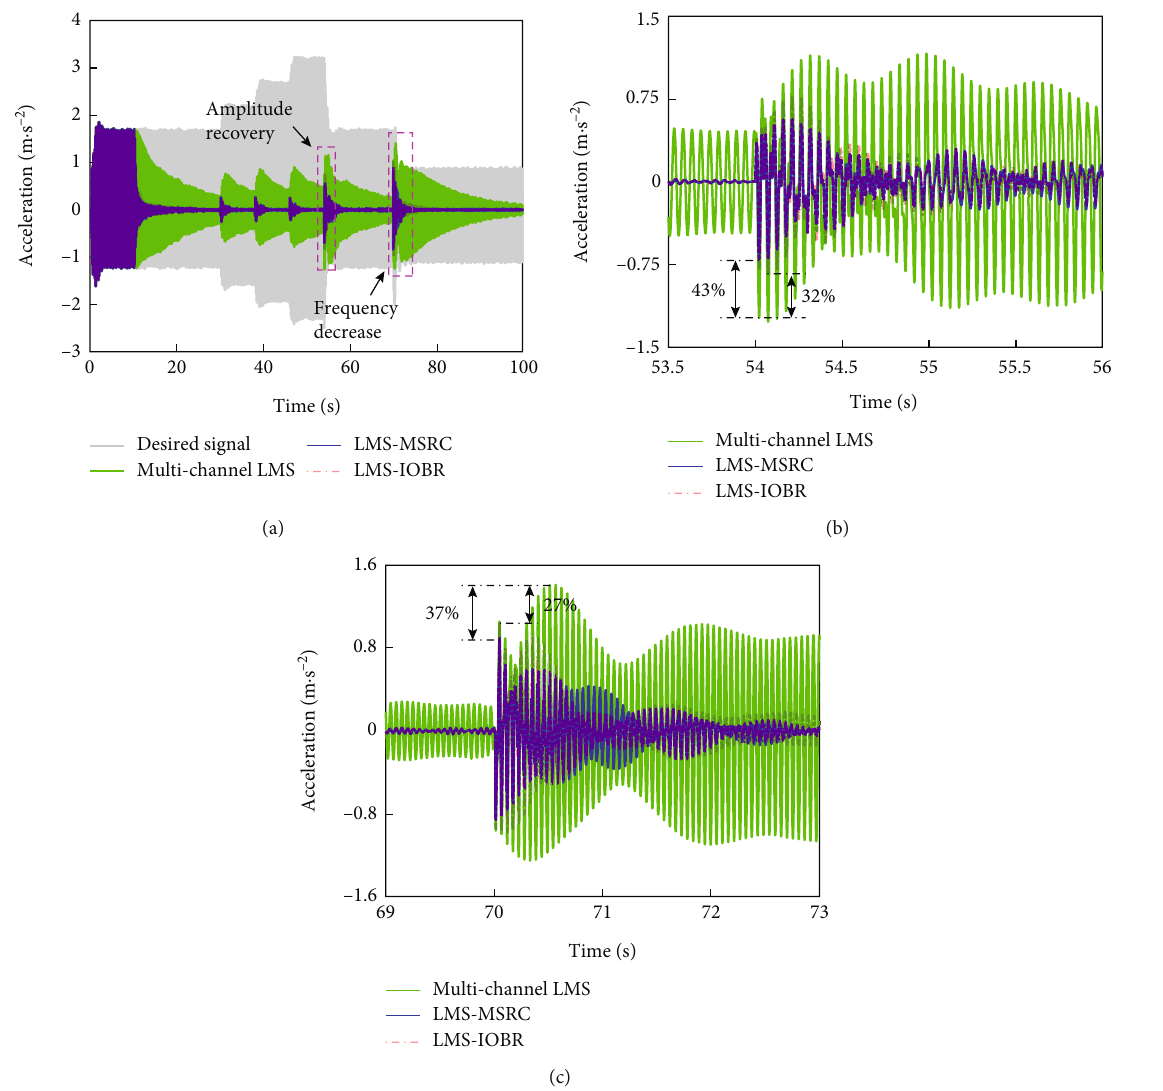
Figure 7: Comparison of acceleration response with 3 di ff erent helicopter ACSR methods. (a) Acceleration response at control point. (b) Control process at amplitude recovery (53.5-56s). (c) Control process at frequency reduction